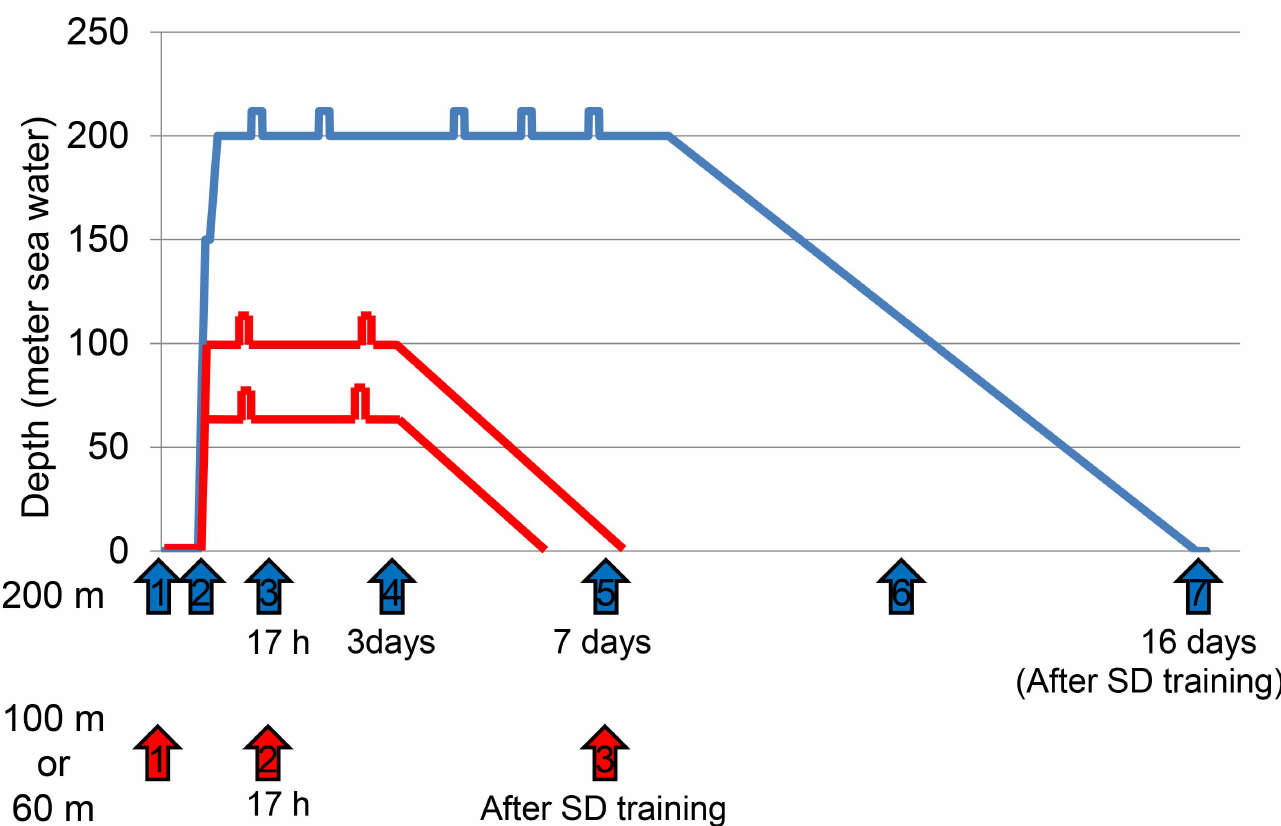
Fig 1. Schedule of blood sampling during saturation diving (SD) at 60, 100, and 200 msw. At 60 msw (n = 4) and 100-msw (n = 5) SD, venous blood was sampled from 9 divers at three time points: just before SD training, 17 h after reaching the respective target depths, and just after SD training. The time points are shown by red arrows (1–3). In 200 msw SD, venous blood was sampled at the same three time points mentioned previously plus 4 additionaltime points (compression phase reached at 100 msw, day 3 and day 7 in the hyperbaric conditionat 200 msw, and the decompression phase at 100 msw). The 7 time points are indicatedby blue arrows (1–7) during SD to 200 msw in 5 of 6